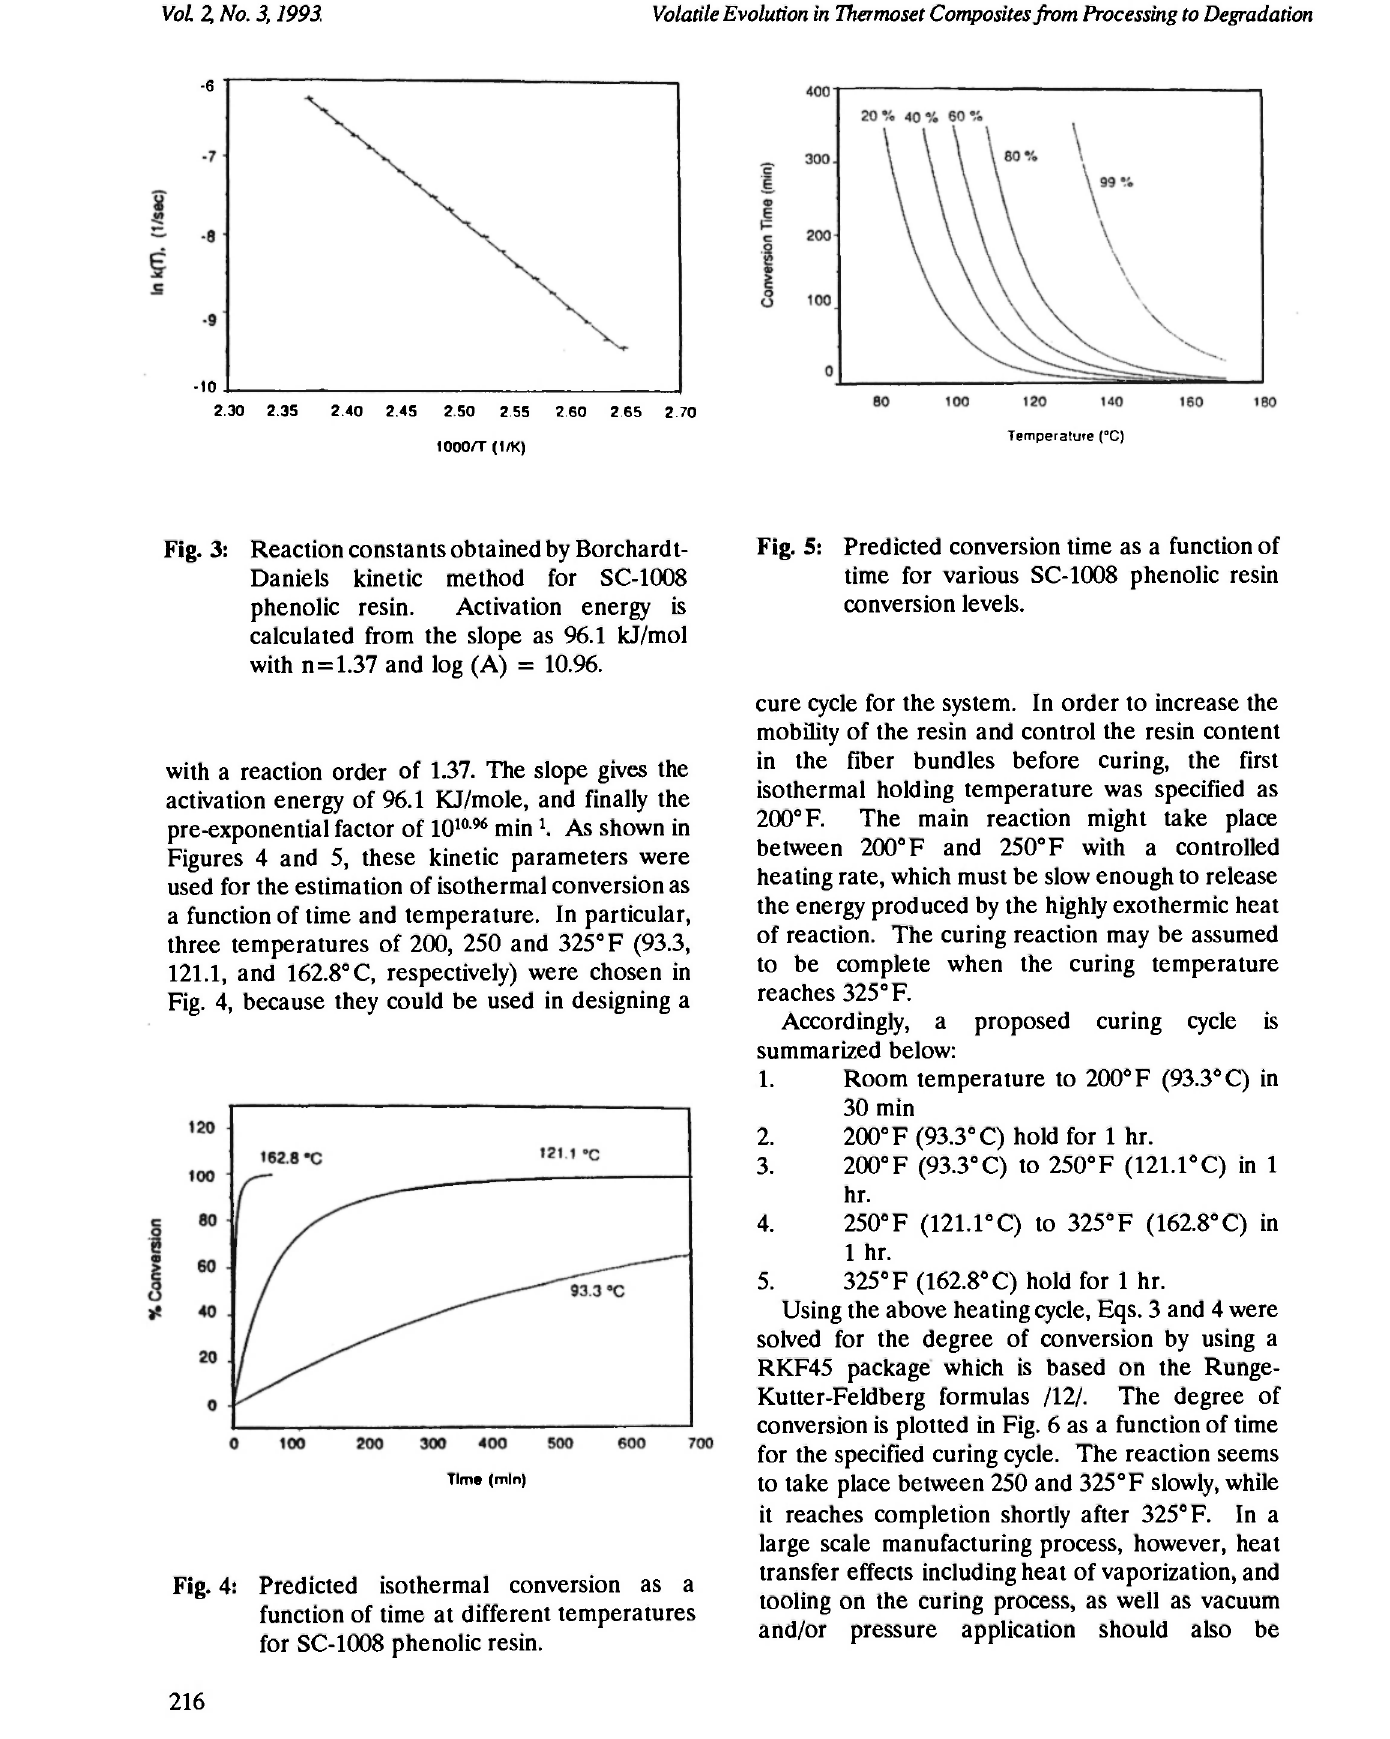
Fig. 4: Predicted isothermal conversion as a function of time at different temperatures for SC-1008 phenolic resin.